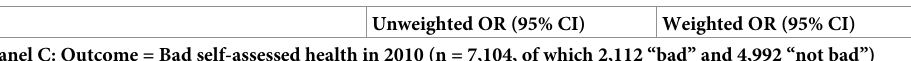
Panel C: Outcome = Bad self-assessed health in 2010 (n = 7,104, of which 2,112 “bad” and 4,992 “not bad”) (Socio-demographic explanatory variables are defined in 2009; diseases 1987–2009; self-assessed variables come from the 2005 survey)